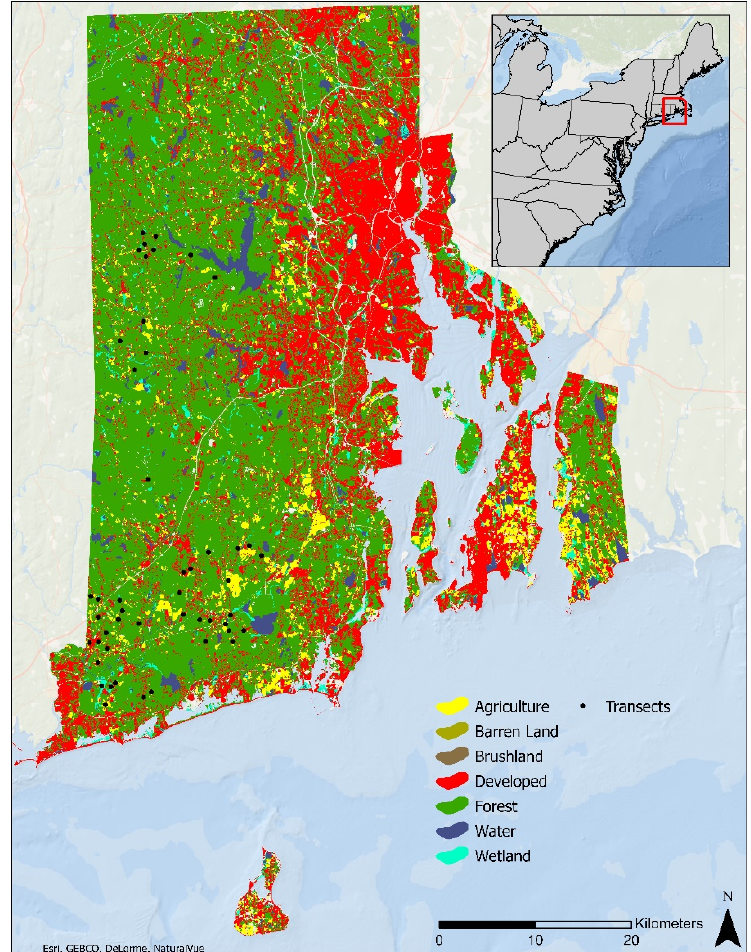
Figure A1. Land use and land cover classification within the study area and the locations of study sites in Rhode Island (USA) from 2019–2021. Table A1. Federal Highway Administration functional class description codes used to estimate traf- fic volume for roads in Rhode Island.